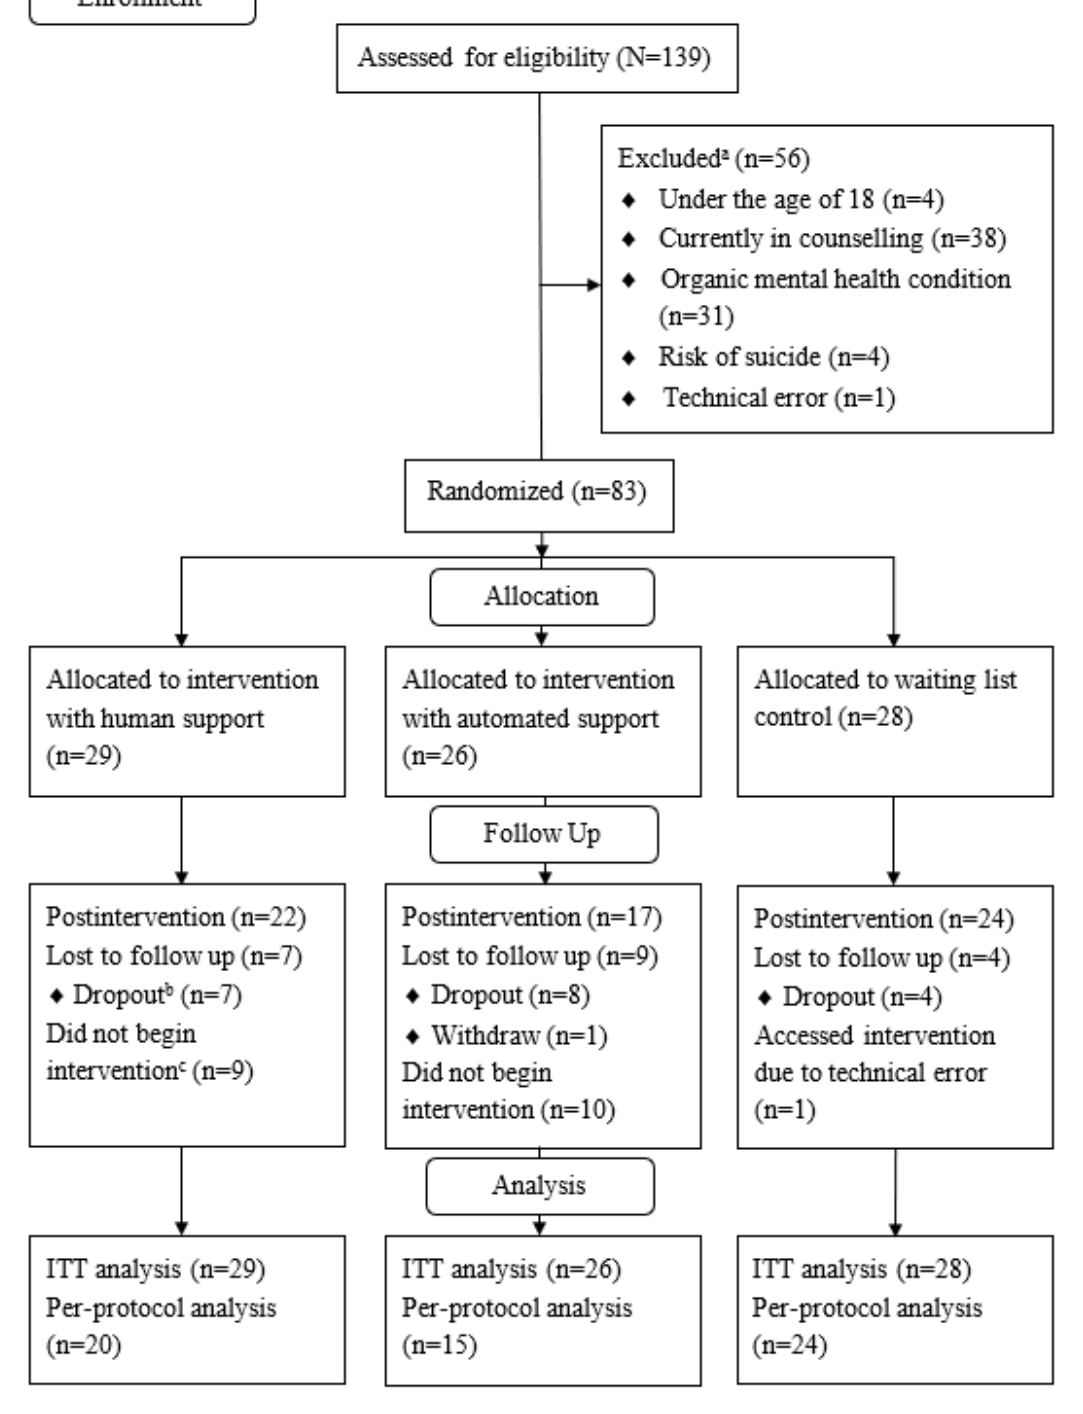
Figure 1. CONSORT flow diagram. ITT: intention to treat. aSome participants met more than 1 reason for exclusion and are categorized as